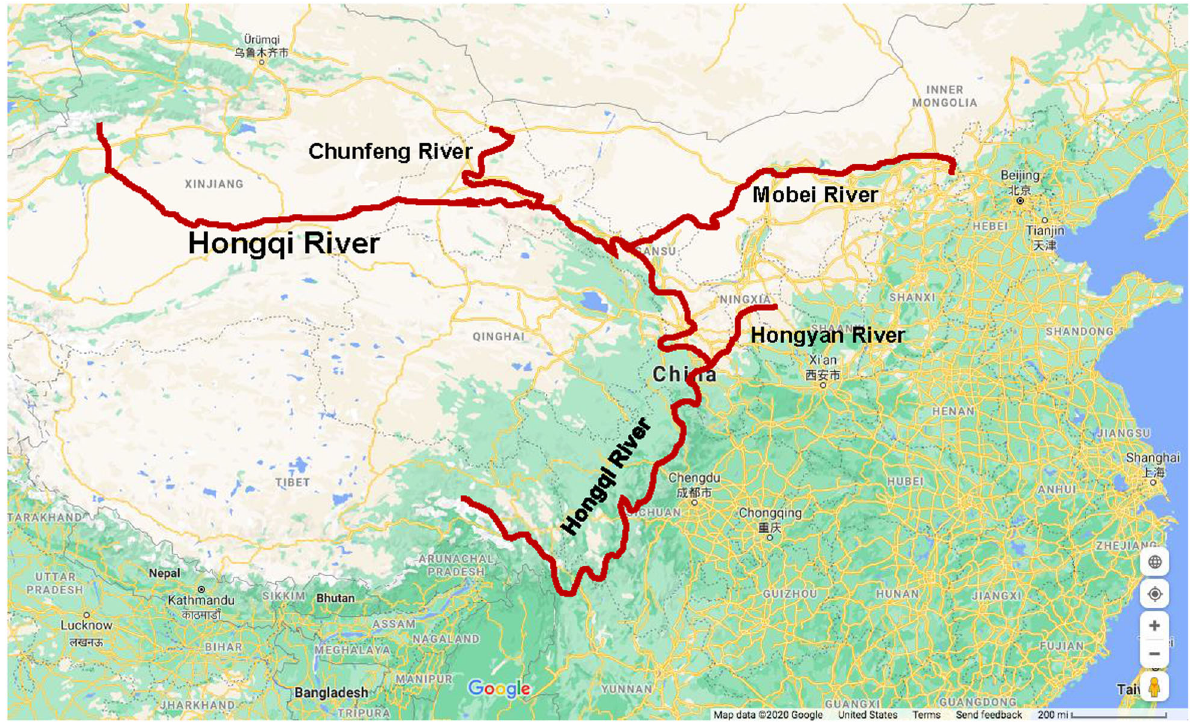
Fig. 4 The diagram of Hongqi River under planning. The red lines represent Hongqi River and its tributaries. Map data: Google